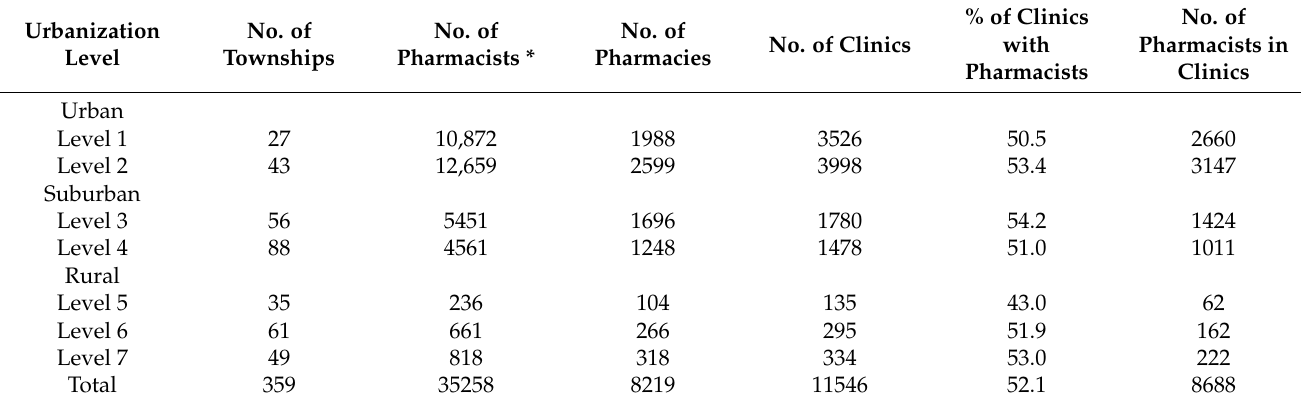
Table 1. Distribution of nationwide pharmacies and the pharmacist workforce at clinics in urban, suburban, and rural areas.